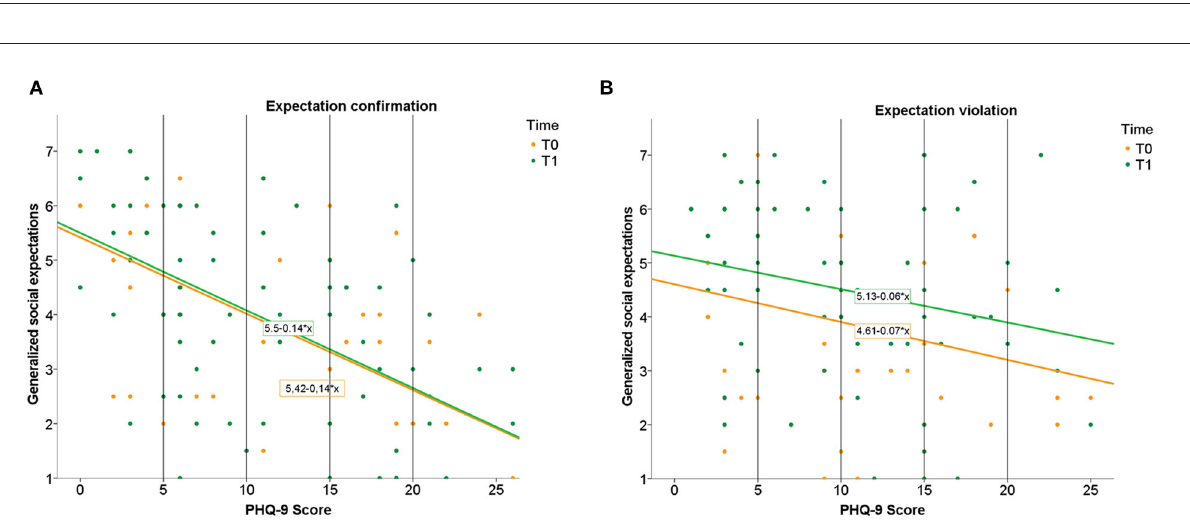
FIGURE4 Illustration of the results for generalized expectation change. Generalized expectations in relation to depressive symptoms (PHQ-9 Score) before and after expectation confirmation (A) and expectation violation (B) . PHQ-9 Score interpretation (vertical lines): 5 to 9 = mild severity, 10 to 14 = moderate severity, 15 to 19 = moderately severe, 20 to 27 =